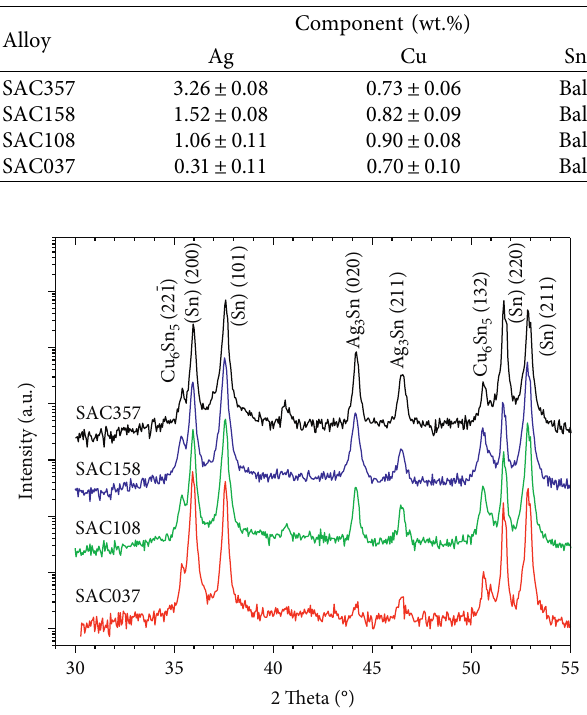
Figure 4: X-ray diffraction patterns of the SAC357, SAC158, SAC108, and SAC037 alloys.